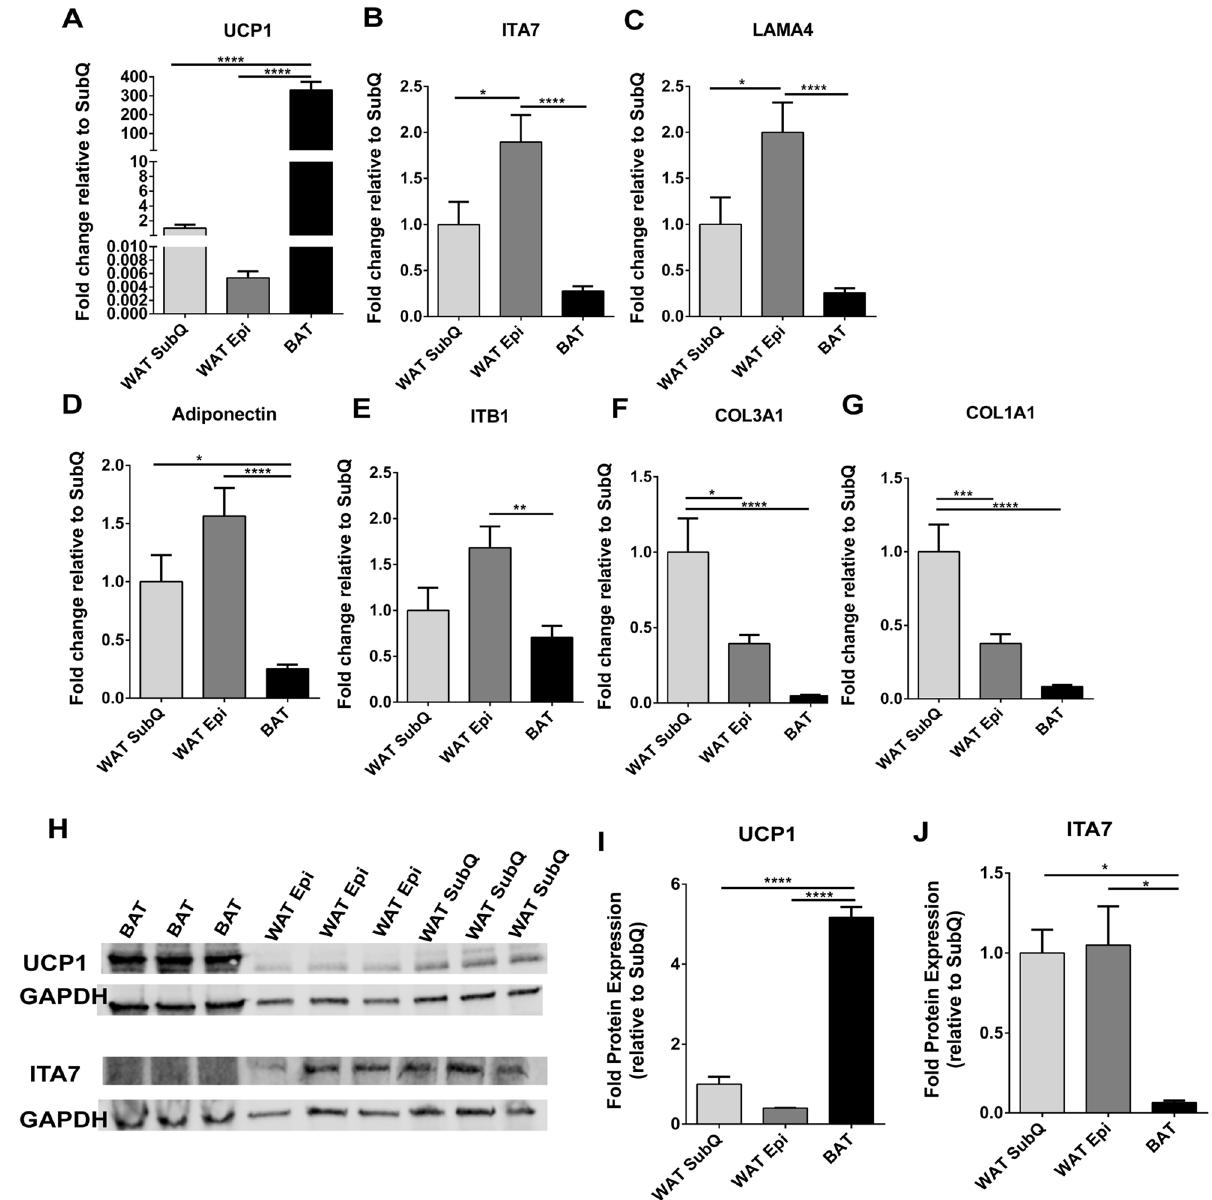
Figure 4. ITA7 and LAMA4 are inversely correlated with the expression of UCP1 in adipose tissue. ( A ) UCP1, ( B ) ITA7, ( C ) LAMA4, ( D ) Adiponectin, ( E ) ITB1, ( F ) CO3A1 and ( G ) CO1A1 fold gene expression in epidydimal white adipose tissue (WAT Epi) and brown adipose tissue (BAT) with respect to subcutaneous white adipose tissue (WAT SubQ). n = 6 animals with two replicates per adipose tissue sample. ( H ) Protein expression of UCP1 and ITA7 in different adipose depots was assessed by western blot. Full-length blots are presented in Supplementary Fig. 5. ( I ) UCP1 and ( J ) ITA7 band intensity was quantifed and normalized to total GAPDH signals. n = 3 animals. Data are presented as mean ± standard error of the mean with * p < 0.05, ** p < 0.01, **** p < 0.0001 as significant from one-way ANOVA followed with Tukey’s multiple comparisons